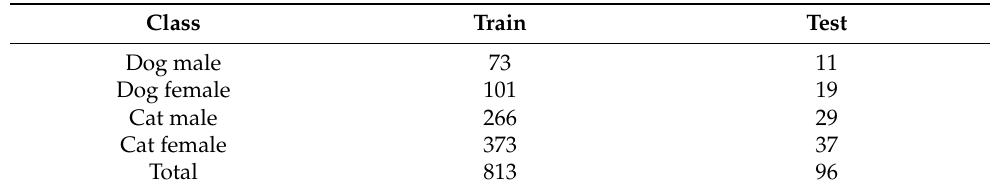
Table 2. Training and test samples for four classes of TNR.